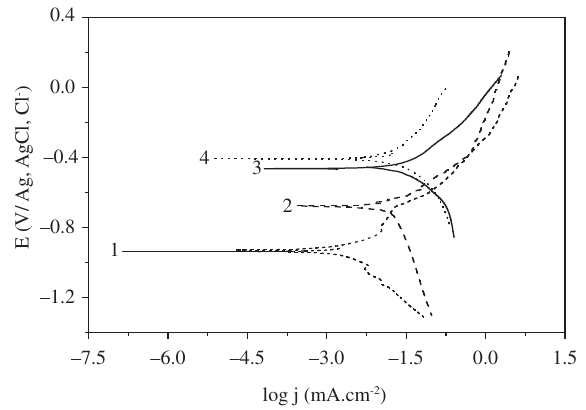
Figure 6. Polarization curves for aluminum surface: 1) just polished; coated with PPy films electrodeposited galvanostatically (2.5 mA.cm -2 ) from pyr- role aqueous solutions containing, respectively, 0.2 mol.L -1 acid: 2) citric; 3) oxalic; and 4) tartaric. Table 1. Electrochemical parameters obtained for aluminum surfaces, just polished and coated with PPy films electrodeposited from aqueous solution contain- ing each aliphatic acid, exposed to a 0.1 mol.L -1 NaCl aqueous solutions. Aluminum